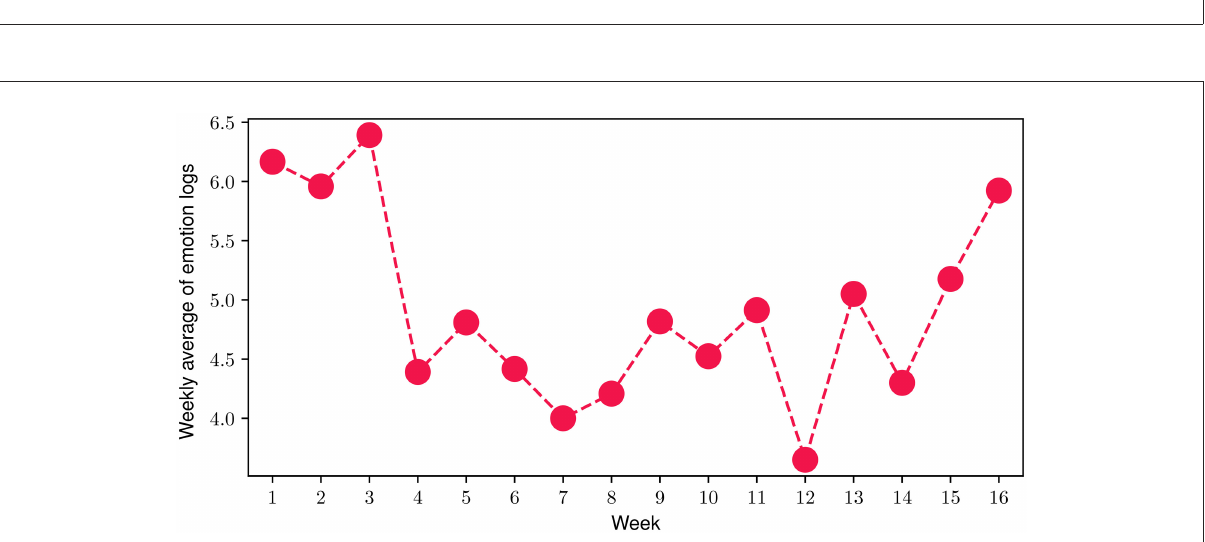
FIGURE6 Weekly average of FES-triggered and manual emotion logs during the